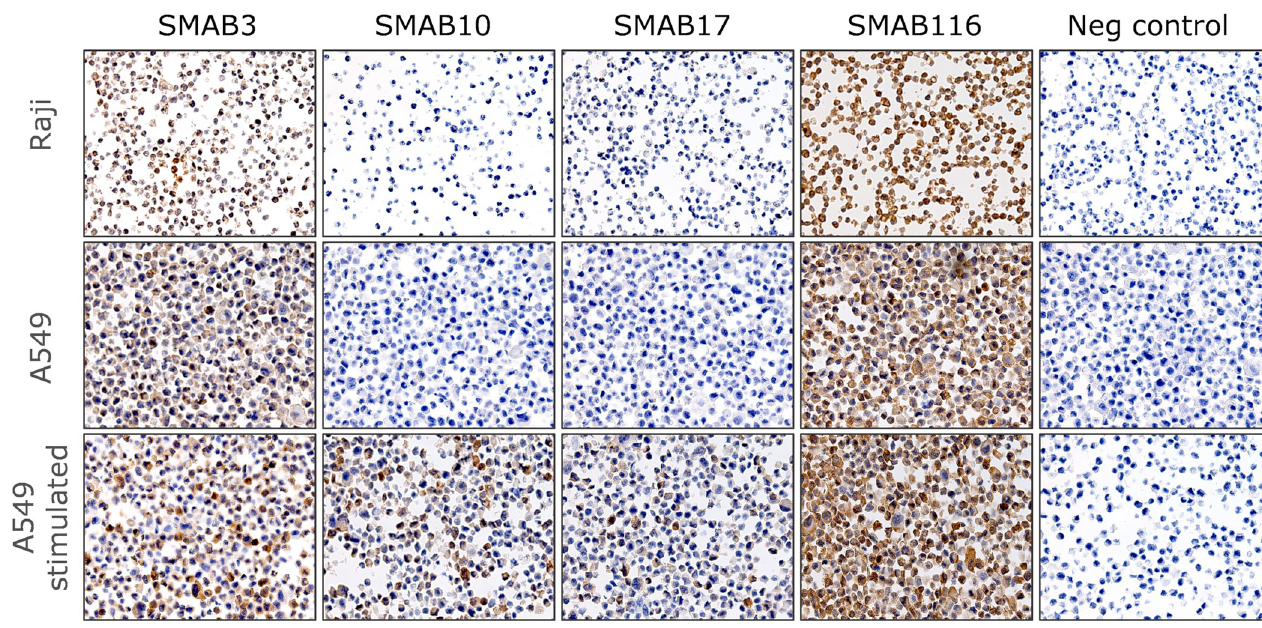
Fig 7. SMABs in immunohistochemistry Immunohistochemistry on paraffin-embedded Raji and A549 cells and A549 cells stimulated with BENSpm.